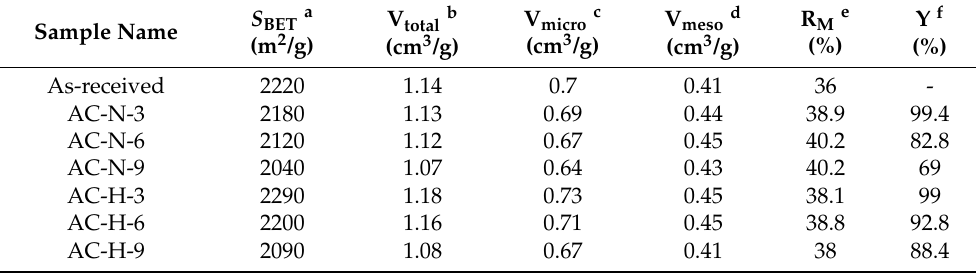
Table 2. Textural properties of AC heat-treated under different